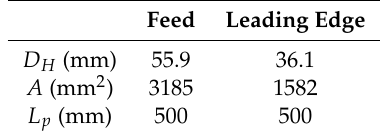
Table 1. Geometric details—passages.